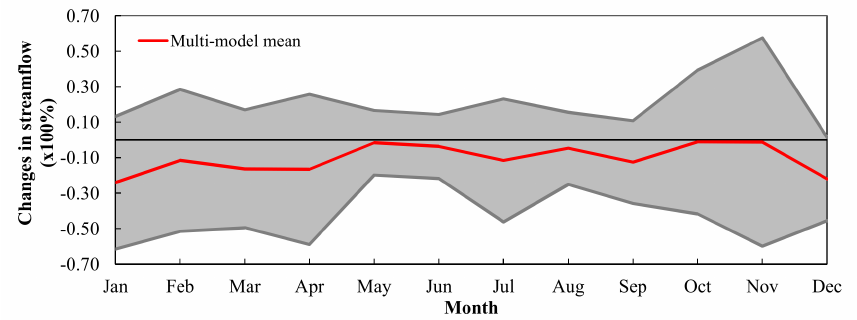
Figure 10. The 95 percent confidence interval of changes in the average monthly streamflow in the near-term (2026–2035) climate simulated using projected rainfall, relative to the baseline (1979–2003)